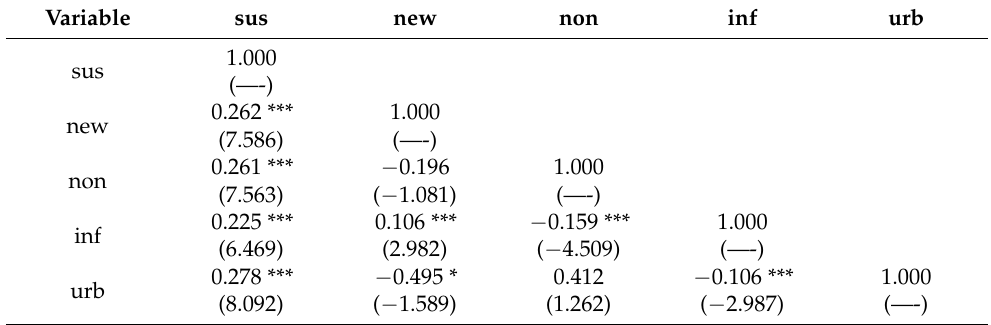
Table 3. Results of correlation